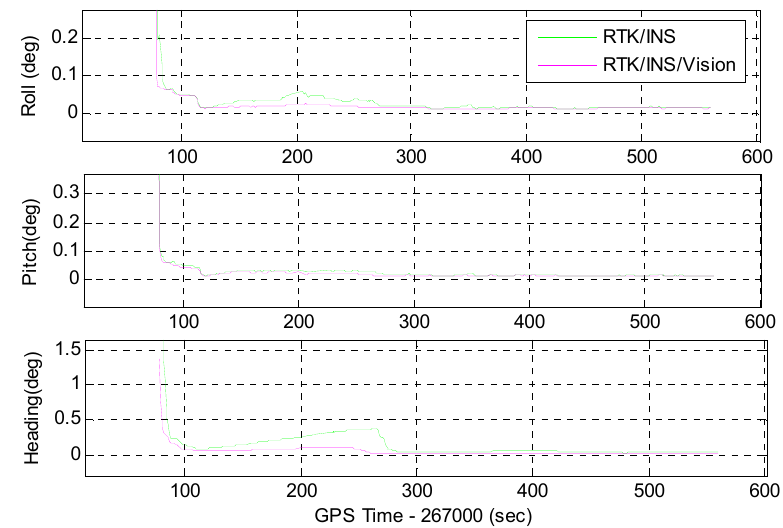
Figure 21. The attitude STD series of the GPS + BDS + GLONASS RTK/INS integration and the corresponding RTK/INS/Vision integration. The STDs are the square roots of the corresponding diagonal elements of the state covariance matrix.